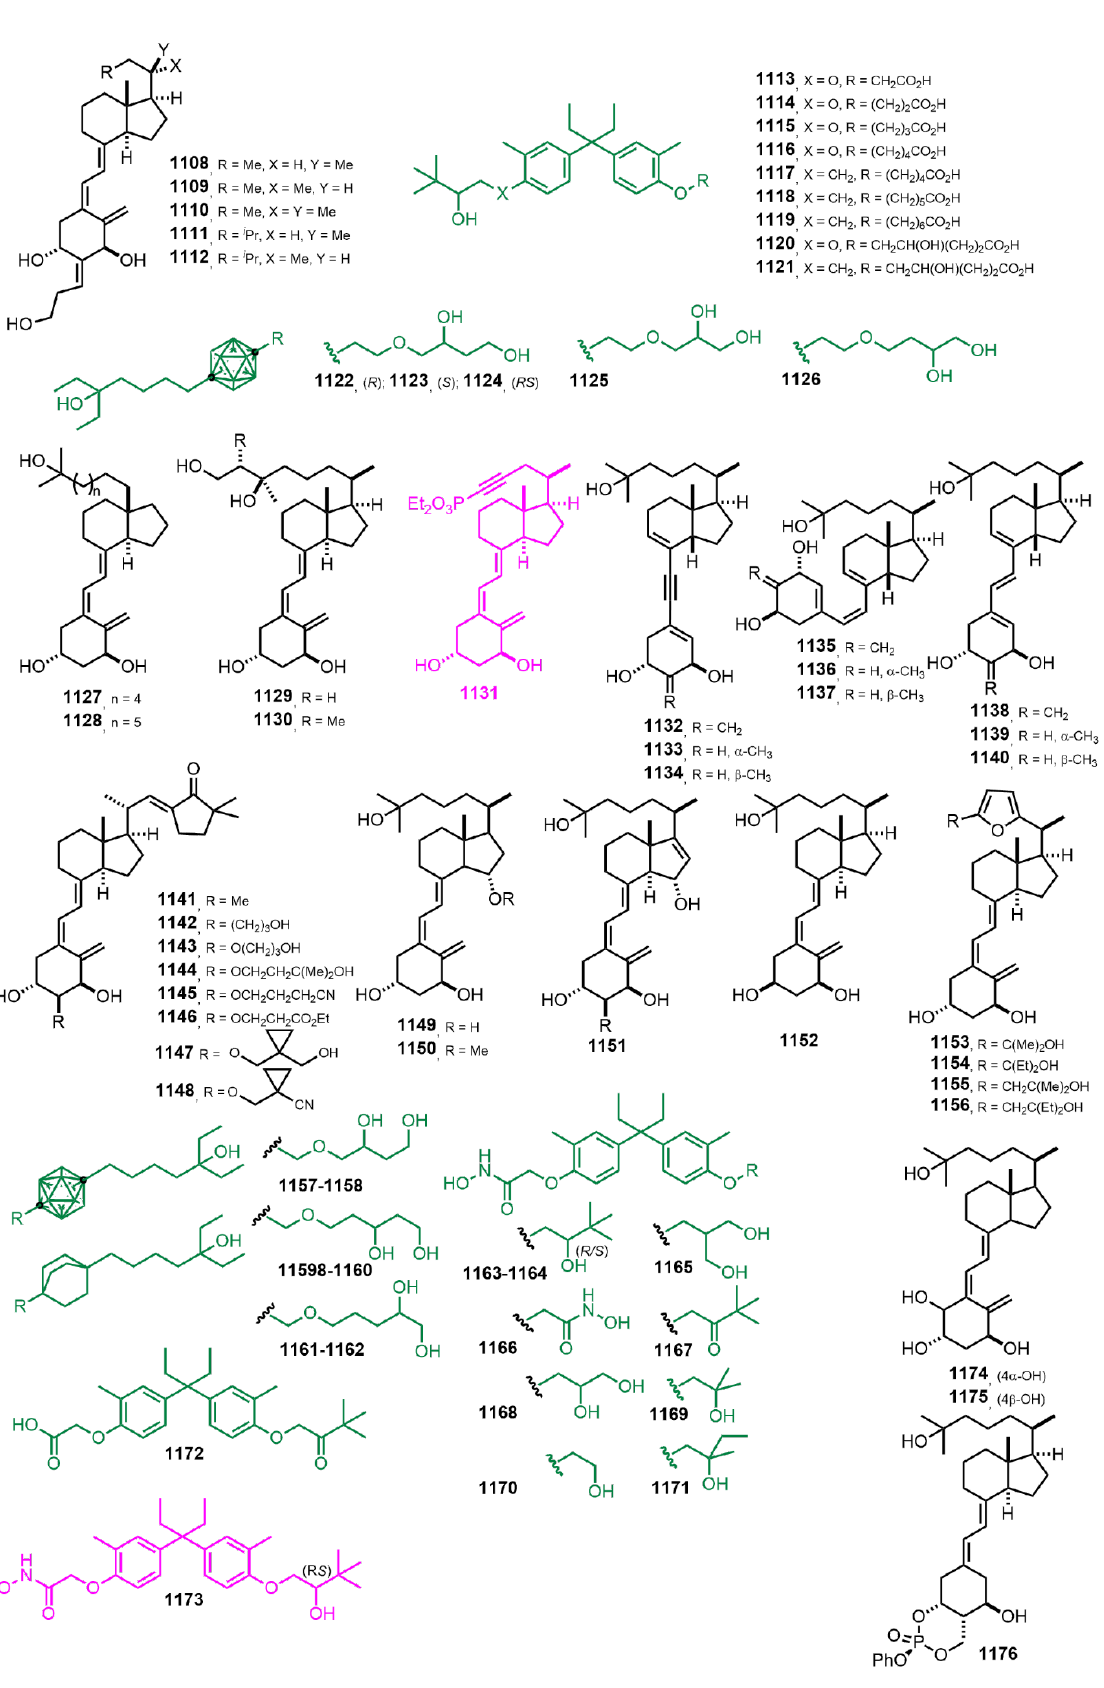
Figure 20. (2010-2012) [284 – 298].